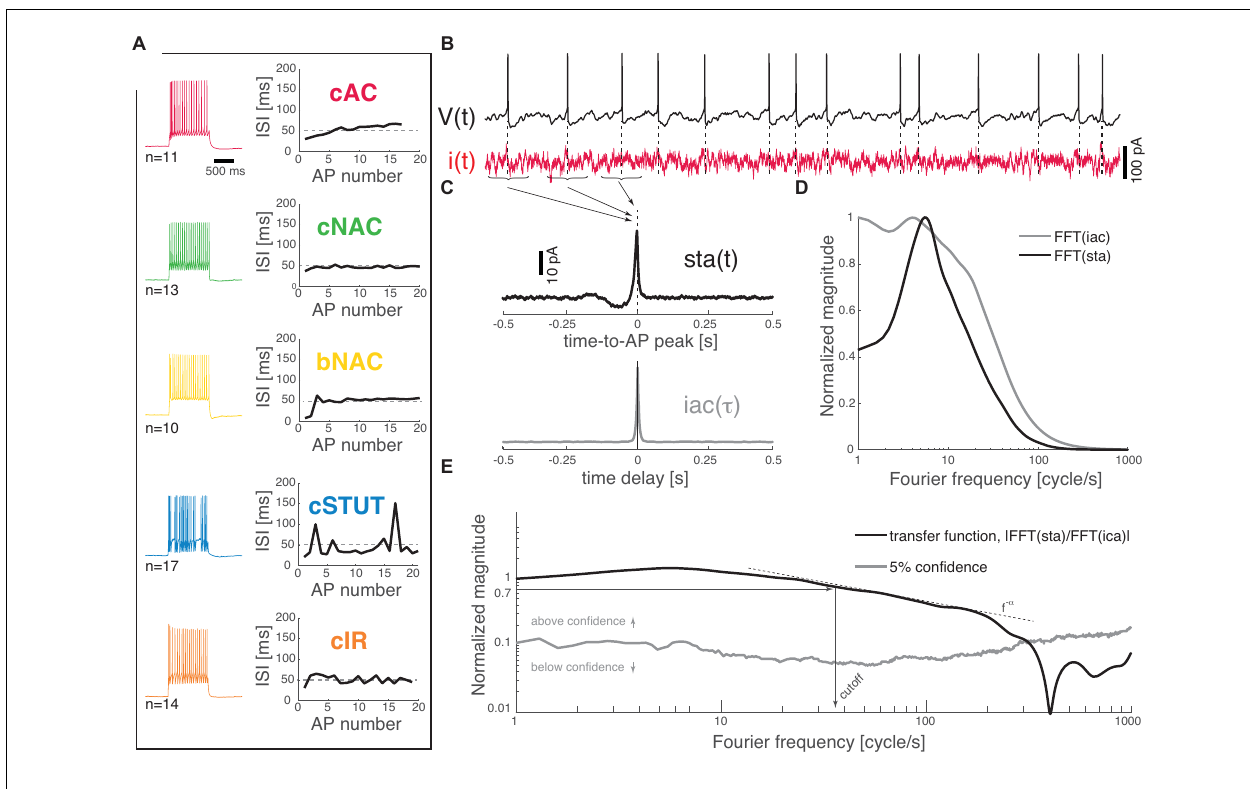
FIGURE 1 | Dynamical transfer function identification in L1 cortical interneurons. Distinct subtypes of L1 interneurons can be distinguished (A) from their electrical response pattern by the sequence of interspike intervals in a 20 spike/s train. These are continuous accommodating, c. non-accommodating, bursting non-accommodating, c. stuttering, and c. irregular. Regardless of their identity, the neurons were stimulated by a fluctuating current i ( t ; B ) while recording their voltage response V ( t ). The spike-triggered average [i.e., sta ( t )] of the stimulus and its autocorrelation function [i.e., iac ( τ )] were computed (C) and fast Fourier-transformed (D) to estimate the neuron dynamical transfer function (E) . As in electronic filters, the magnitude of this function expresses the intensity of the output firing rate of the cell across temporal modulations or Fourier components of an input signal, thus revealing the bandwidth of spike initiation dynamics. The cut off was characterized—above significance (see “Materials and Methods” section)—as the frequency corresponding to a 70% decrease of the response magnitude of the value taken at 1 cycle/s. The high-frequency profile was finally described as a f − α